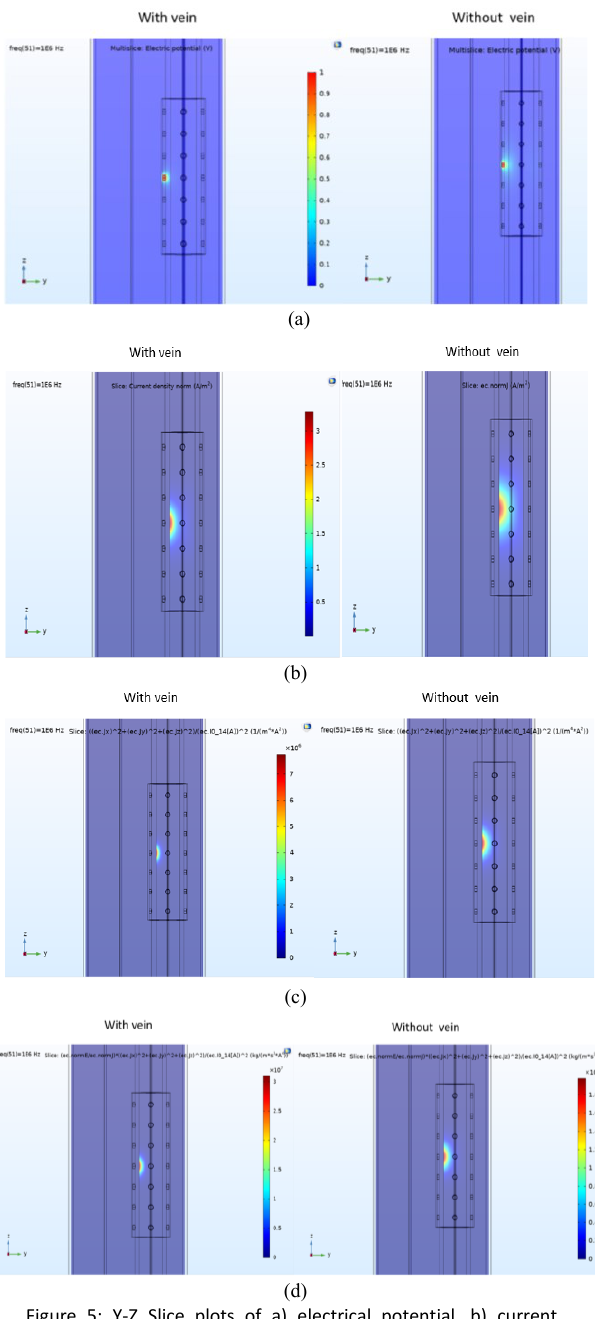
Figure 5: Y-Z Slice plots of a) electrical potential, b) current density, c) sensitivity and d) volume impedance density for the model with 28 surface electrodes simulated with and without the vein at the frequency of 1 MHz where only the middle electrode was excited as the terminal (radius of the ground electrode = 0.5 mm, radius of the terminal electrode = 1 mm).